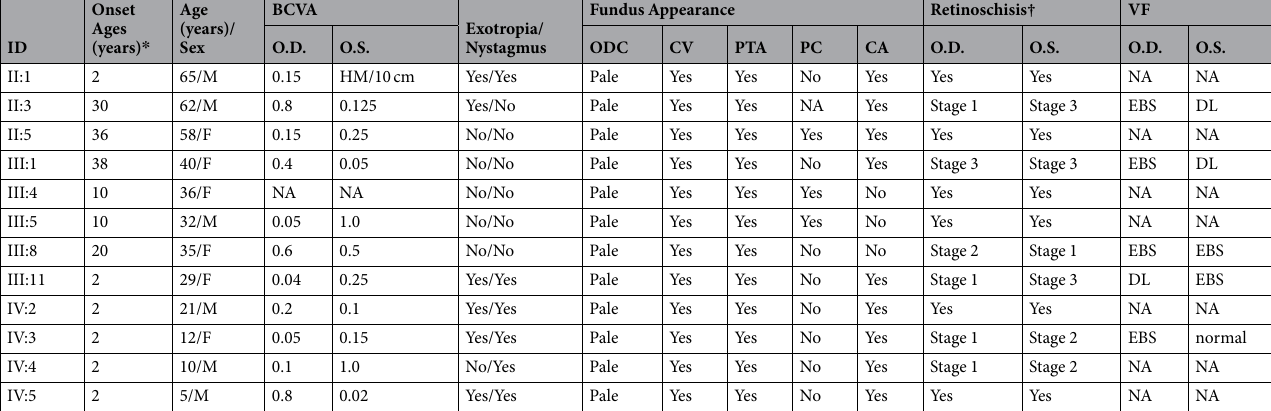
Table 1. Clinical features of patients from family CL. Abbreviations: F: female; M: male; BCVA: best corrected visual acuity; O.D.: right eye; O.S.: left eye; HM: hand moving; NA: not available; ODC: optic disk color; CV: cilioretinal vessels; PTA: peripapillay textural anomaly; PC: pigmental change; CA: choroidal atrophy; VF: visual field; EBS: enlarged blind spot; DL: difussed loss. * Onset ages of visiual impairment; †stages of retinoschisis was determined based on SD-OCT images.